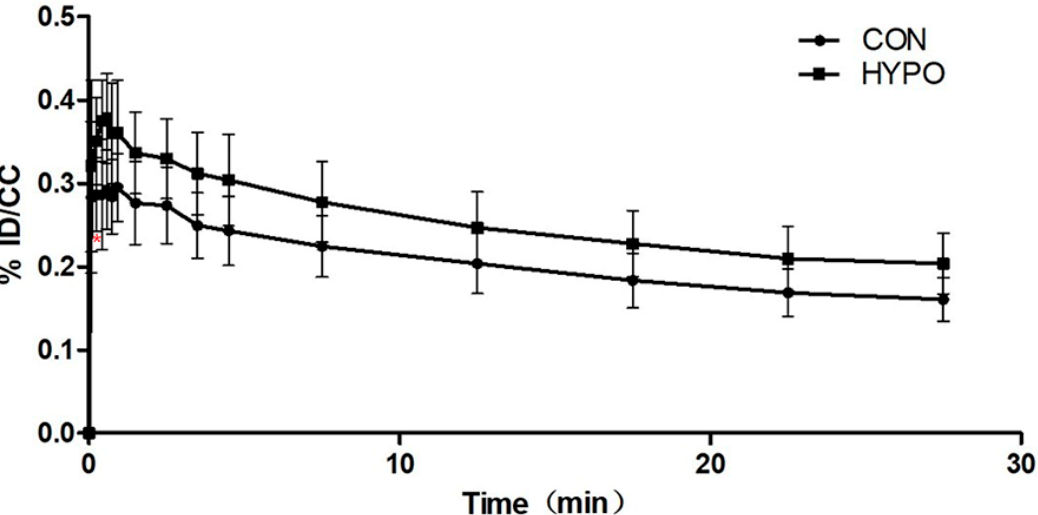
DPA-714 images of a control and a hypothyroid rat.